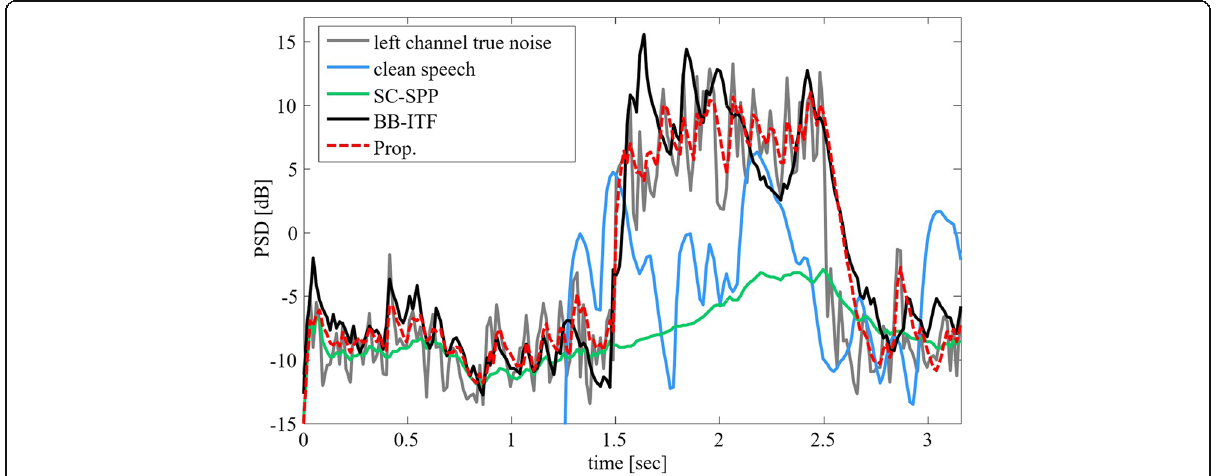
Fig. 10 The tracking performance results from SC-SPP, BB-ITF, and Prop with a sudden increase and decrease of noise power